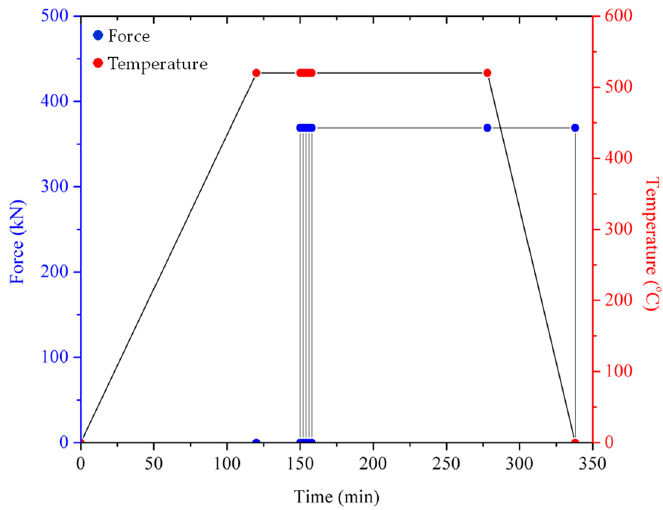
Figure 2. Force and operating temperature over time.